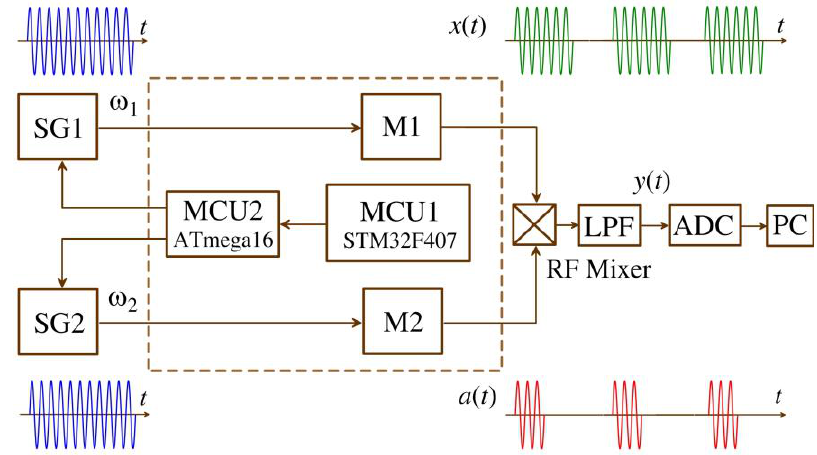
Fig. 3. Layout of radio pulse stroboscopic